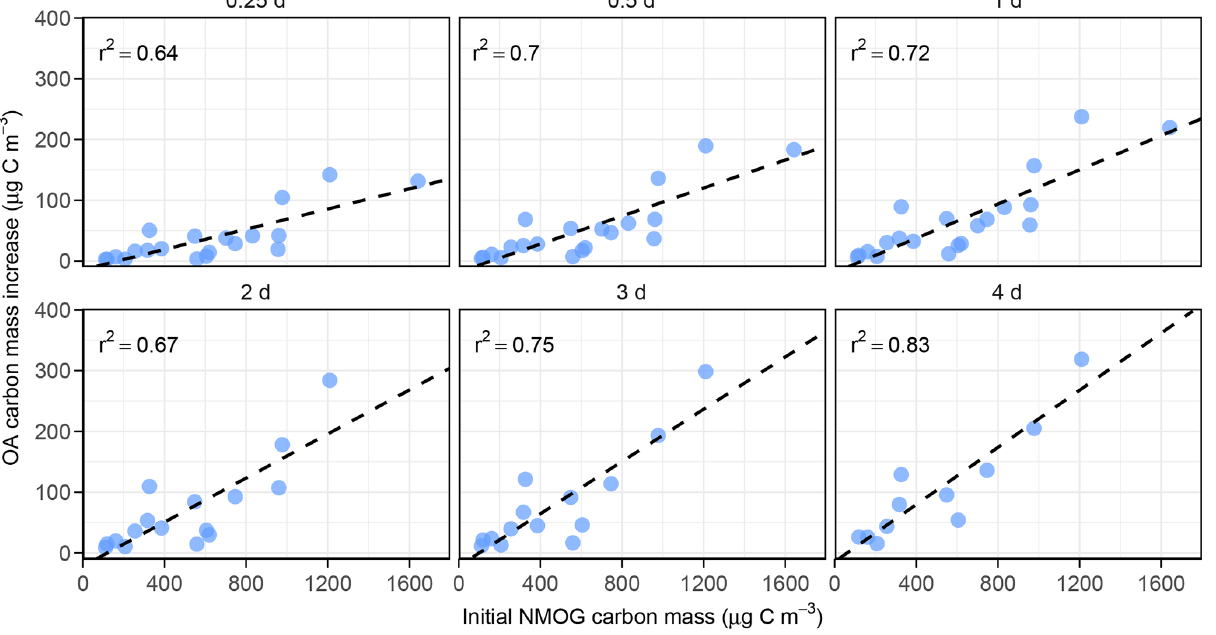
Figure 3. OA carbon mass added vs. initial NMOG carbon mass from PTR-ToF-MS measurements at various OH exposures (0.25–4d of equivalent atmospheric aging). All panels show correlation coefficients ( r 2 ) of 0.64 or higher, and the linear relationships at longer aging times show larger slopes (i.e., more SOA; see Fig. 6).